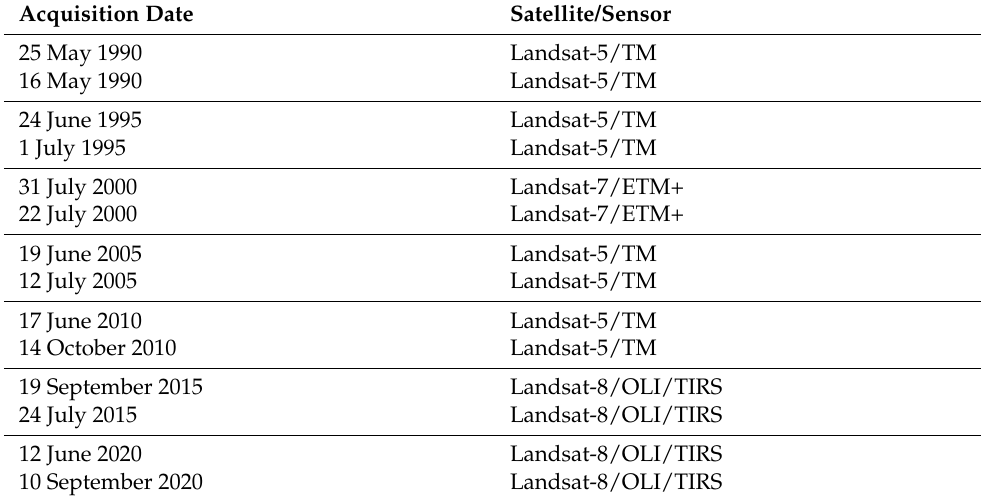
Table 1. Landsat images used in this study.